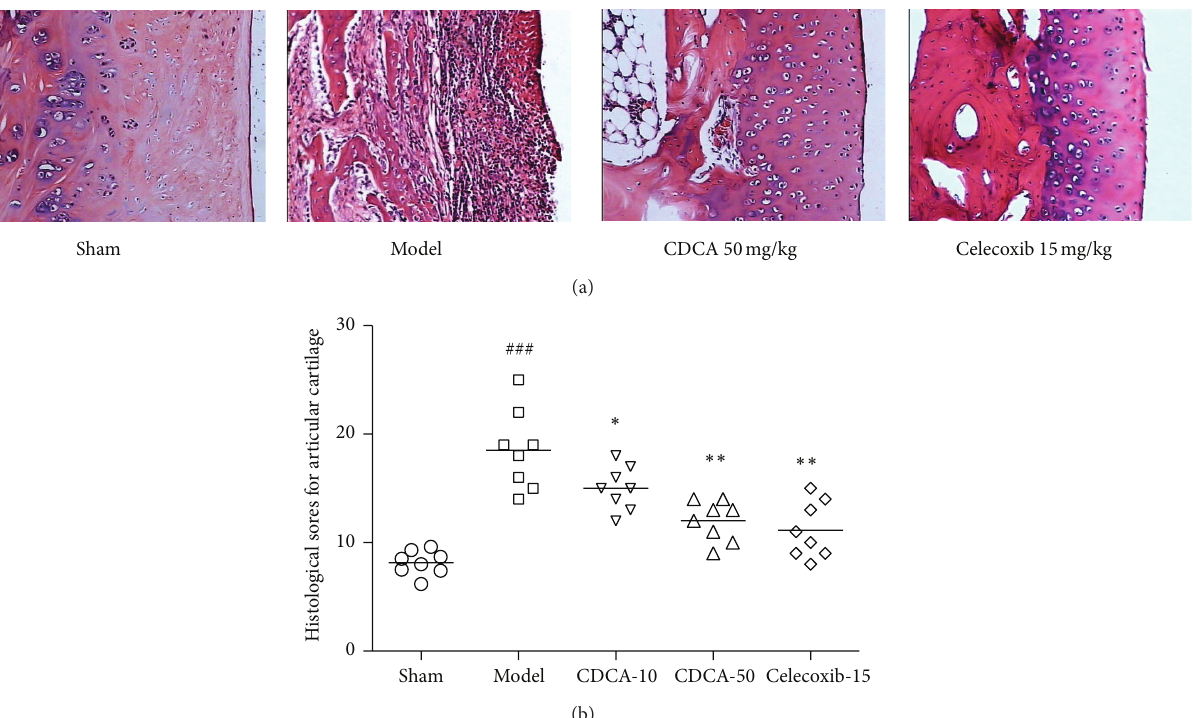
Figure 2: (a) Representative hematoxylin-eosin (HE) stained sections of articular cartilage are shown. Magnification 100x. (b) Histological sores for articular cartilage in the five groups of experimental rabbits. Results are presented as individual data points and the median for each group is indicated by a horizontal bar. ### 𝑃 < 0.001 , compared with the sham-operation group; ∗ 𝑃 < 0.05 , ∗∗ 𝑃 < 0.01 , compared with the model group. Similar results were observed in two separated